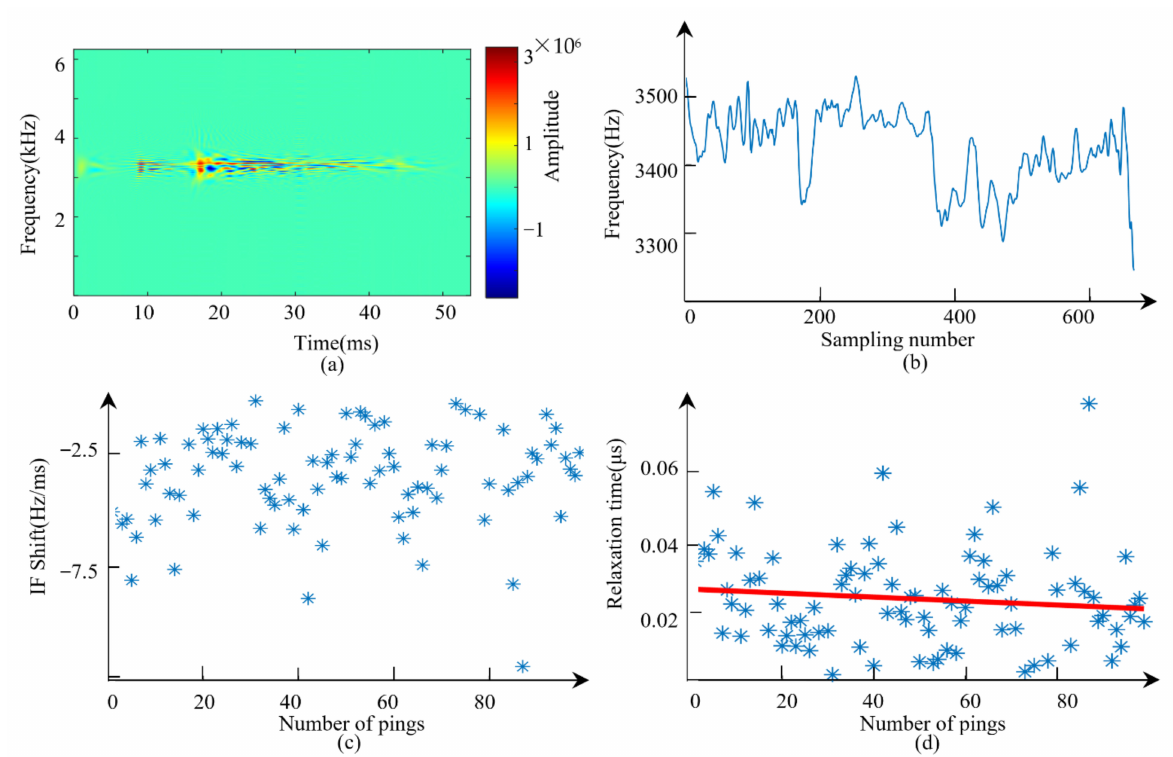
Figure 6. Illustration of WVD, IF series, and the relaxation time map. ( a ) The WVD result of one mode. ( b ) The IF series data of one ping. ( c ) The IF shift data of 101 pings. ( d ) The relaxation time map and the robust line fitting based on relaxation time